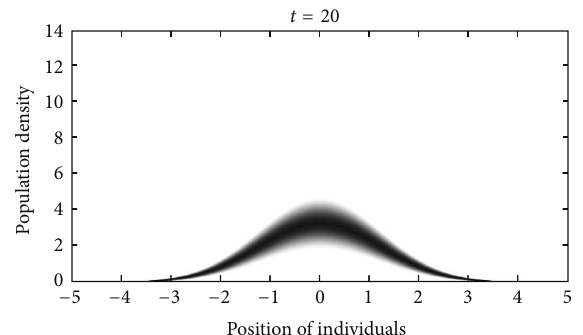
Figure 9: Fuzzy two-dimensional graph of the solution for 𝑡 = 1 involving advection-diffusion-reaction to (𝑎,𝑐) = (0,0) and 𝑏 = 1 .